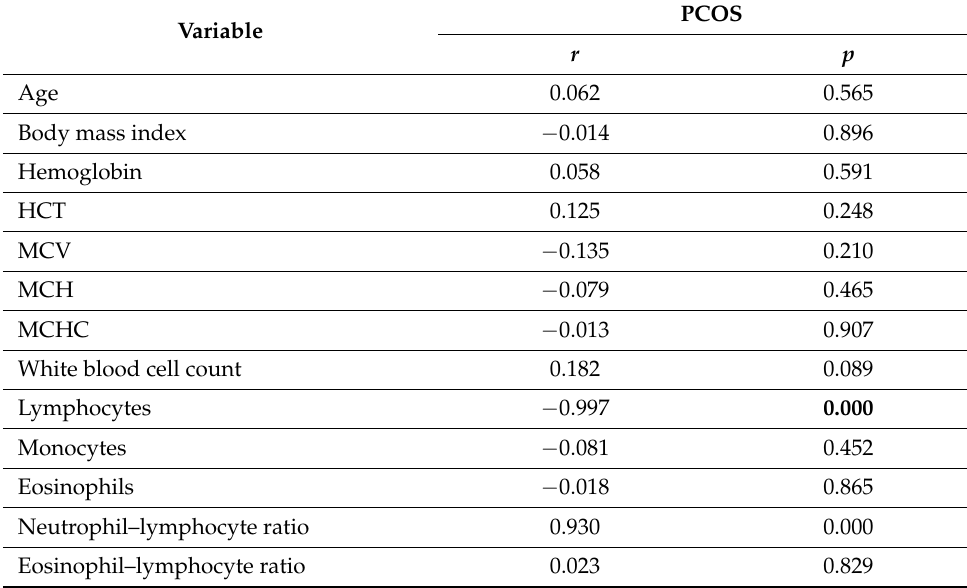
Table 2. Pearson’s correlation analysis of neutrophil count vs. the independent laboratory variables investigated in women with polycystic ovary